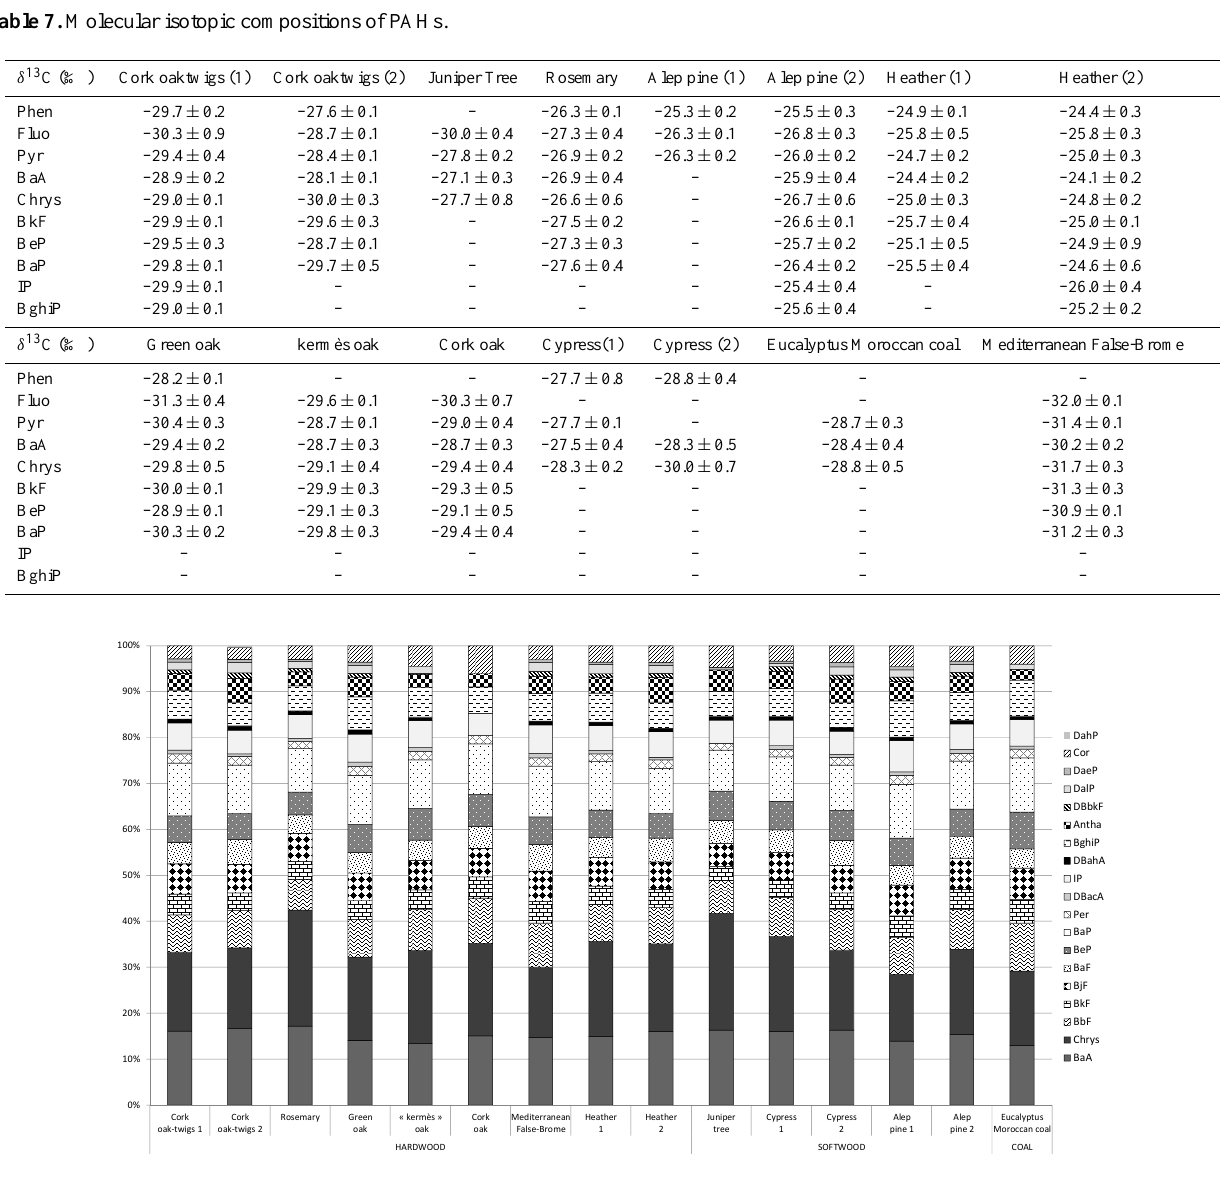
species, except for sugarcane combustion. Indeed, this plant is a “C 4 plant” including a photosynthetic pathway differ- ent from other studied woods which are “C 3 plants”. This difference may be explained by the way of PAH forma- tion during the combustion of both plant families.